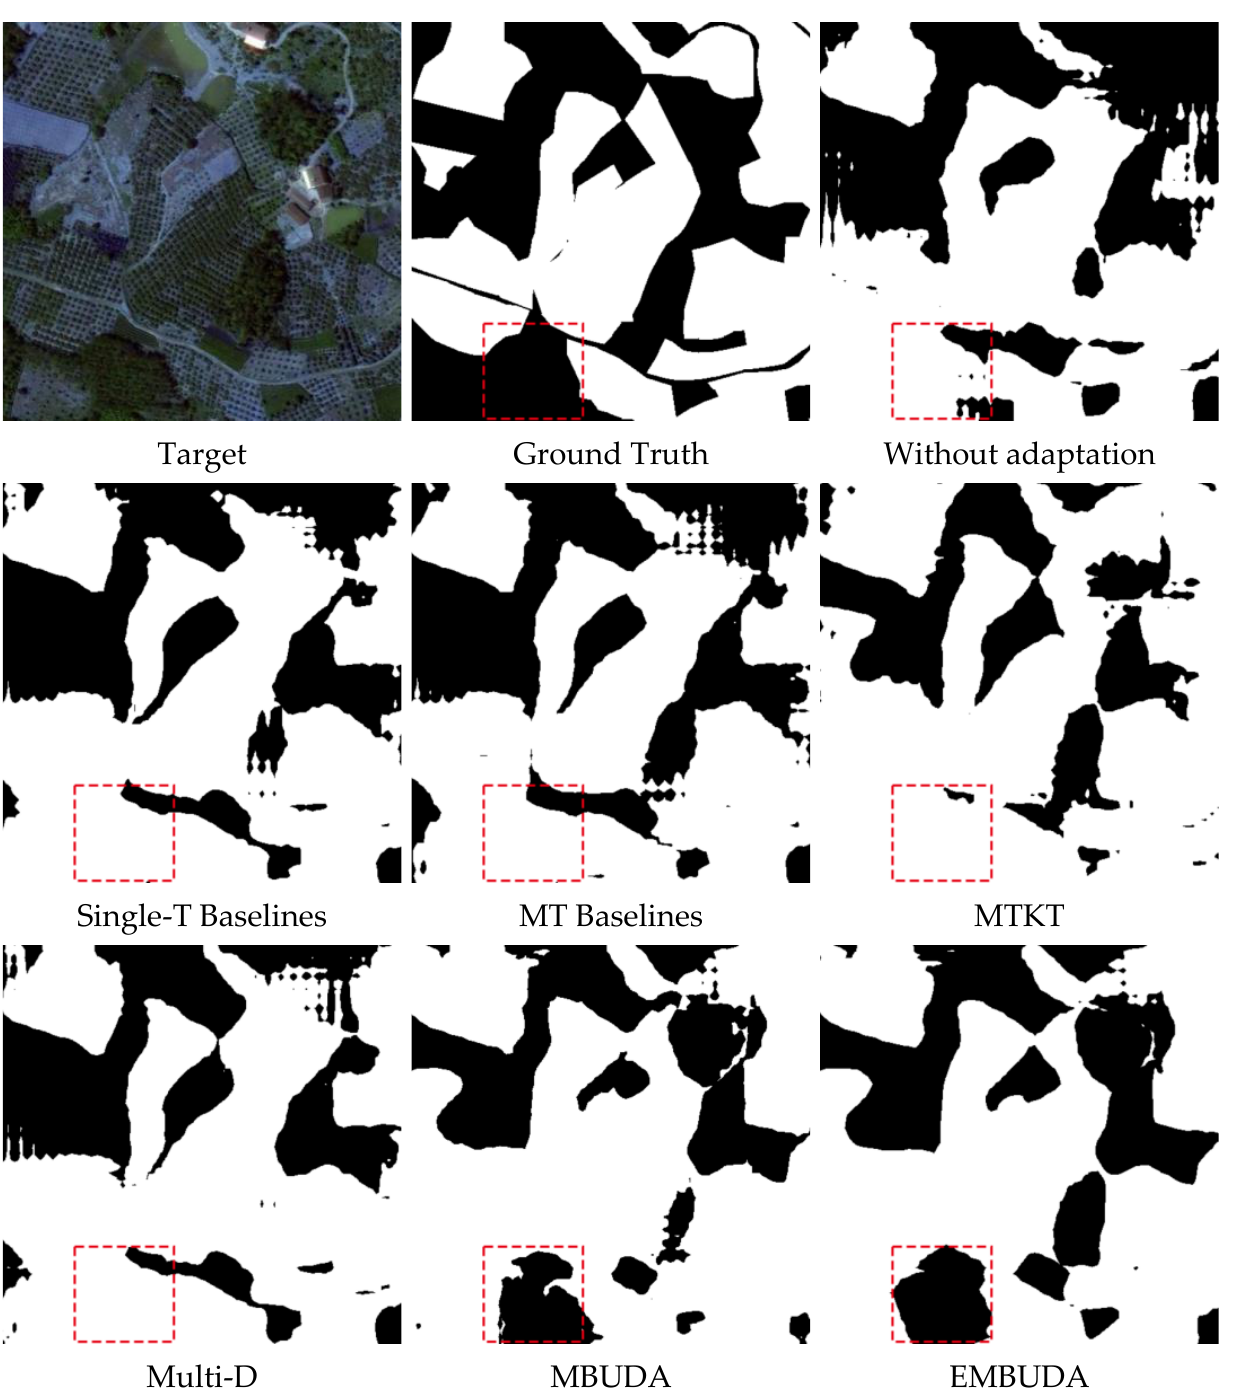
Figure A5. Outputs of orchard area segmentation in Dataset XT1 when adapting from Dataset CY to Dataset XT1 and Dataset XT2.